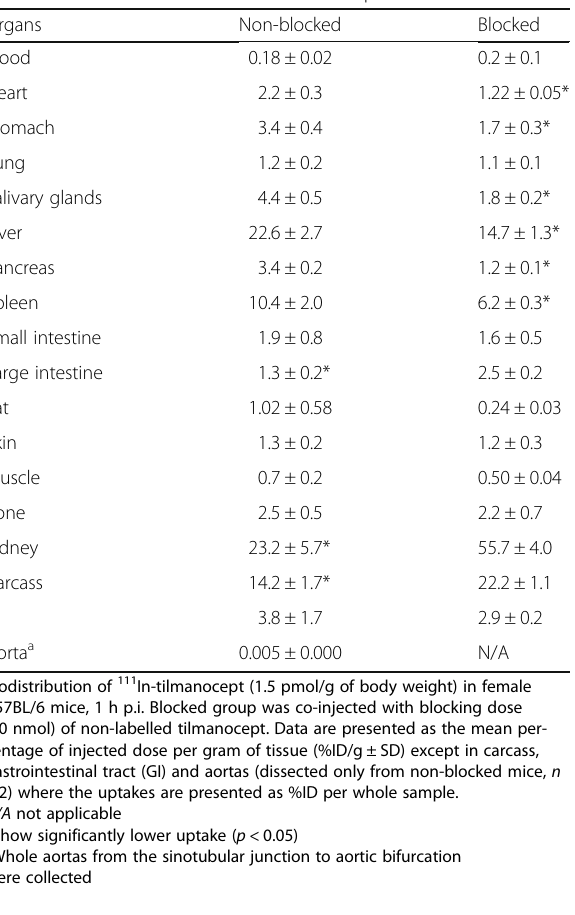
Table 1 Biodistribution of 111 In-tilmanocept